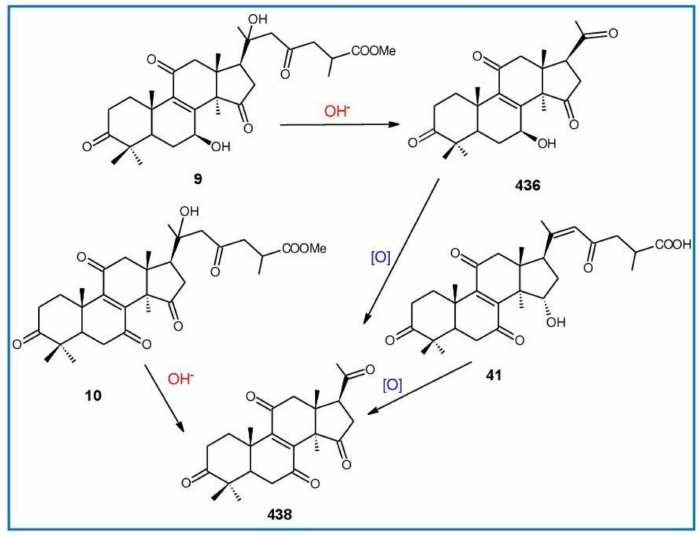
Figure 16. Retro-aldol condensations and oxidation of compounds 436 and 438